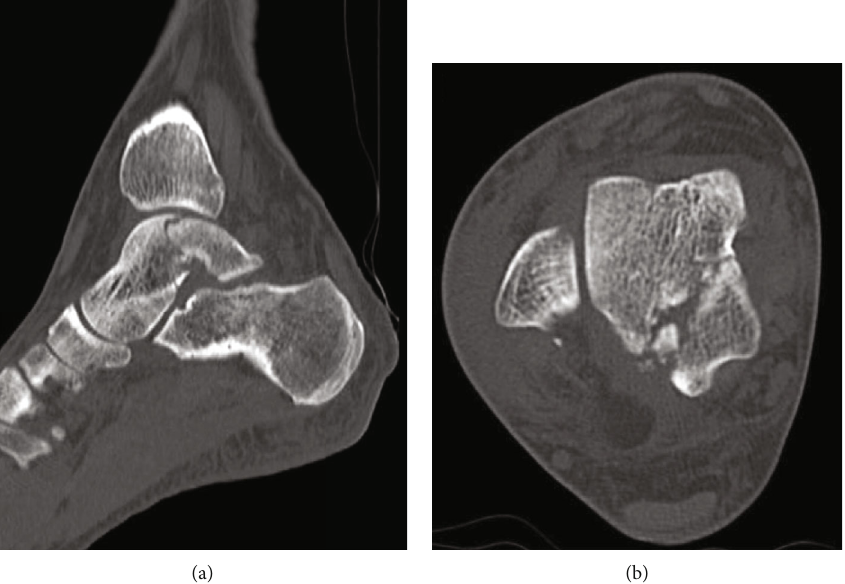
Figure 2: Preoperative noncontrast CT in (a) sagittal and (b) axial views demonstrated the fracture line from the lateral side of the posterior lateral process to the posteromedial side of the talus body. In addition, the fracture line extended to the posterior ankle and subtalar joints, and the bone fragment was slightly